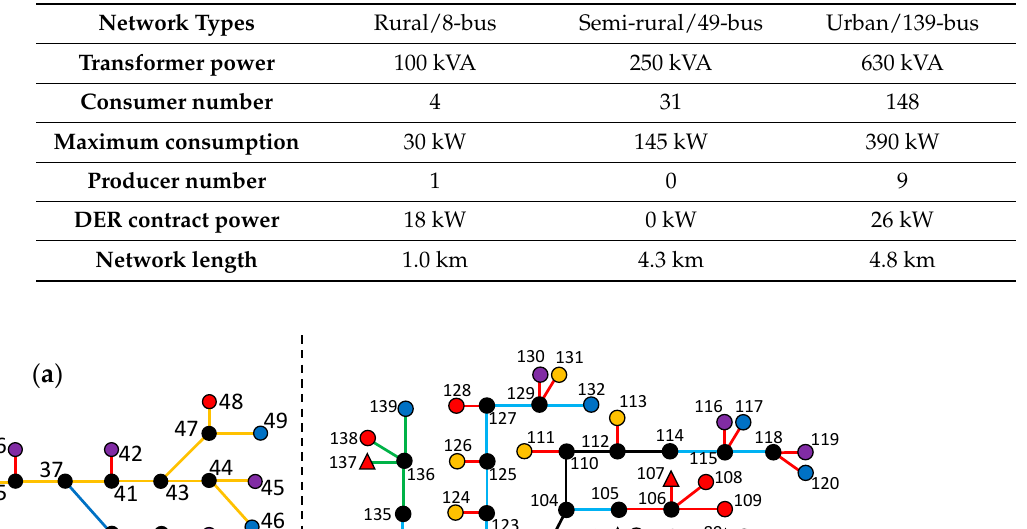
Table 9. Parameters of LV network types.